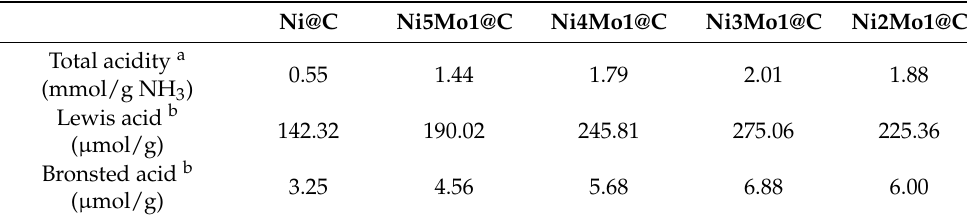
Table 2. Total acidity and Brønsted acid and Lewis acid distribution in Ni-based catalysts derived from Ni-MOF and